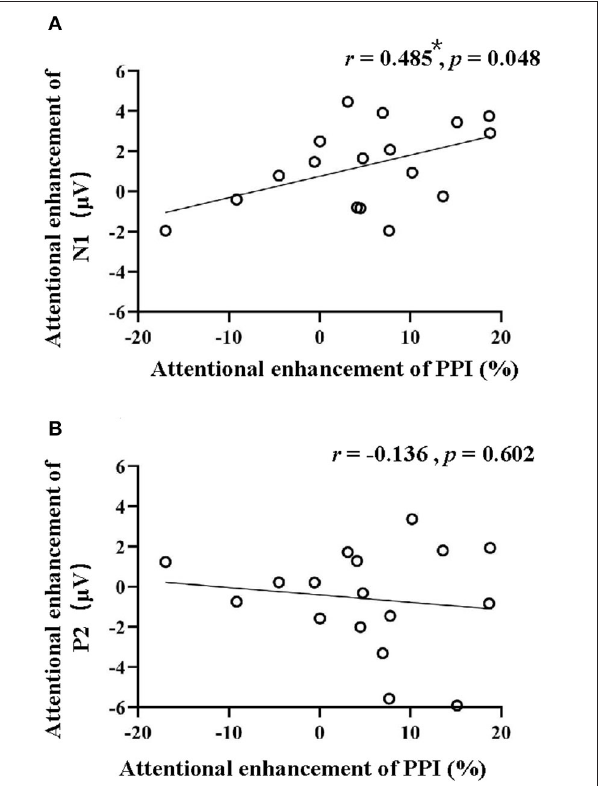
FIGURE 4 | Correlations between the attentional enhancement of PPI and the attentional enhancement of N1 (A) and P2 (B) . * p < 0.05. a discrete prepulse of 20 ms (Poje and Filion, 2021).